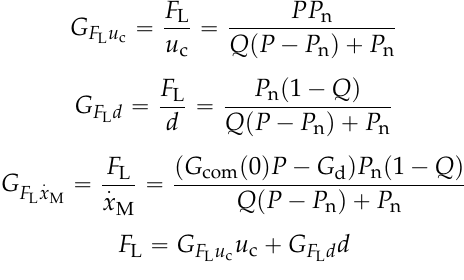
Figure 7. Disturbance observer (DOB) structure for the compensated system.